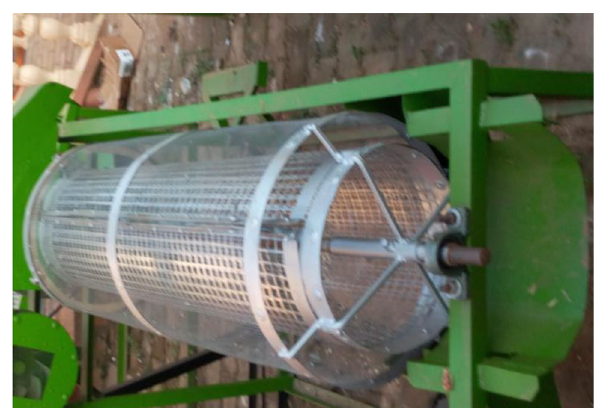
Fig. 2 Sieves rotating in